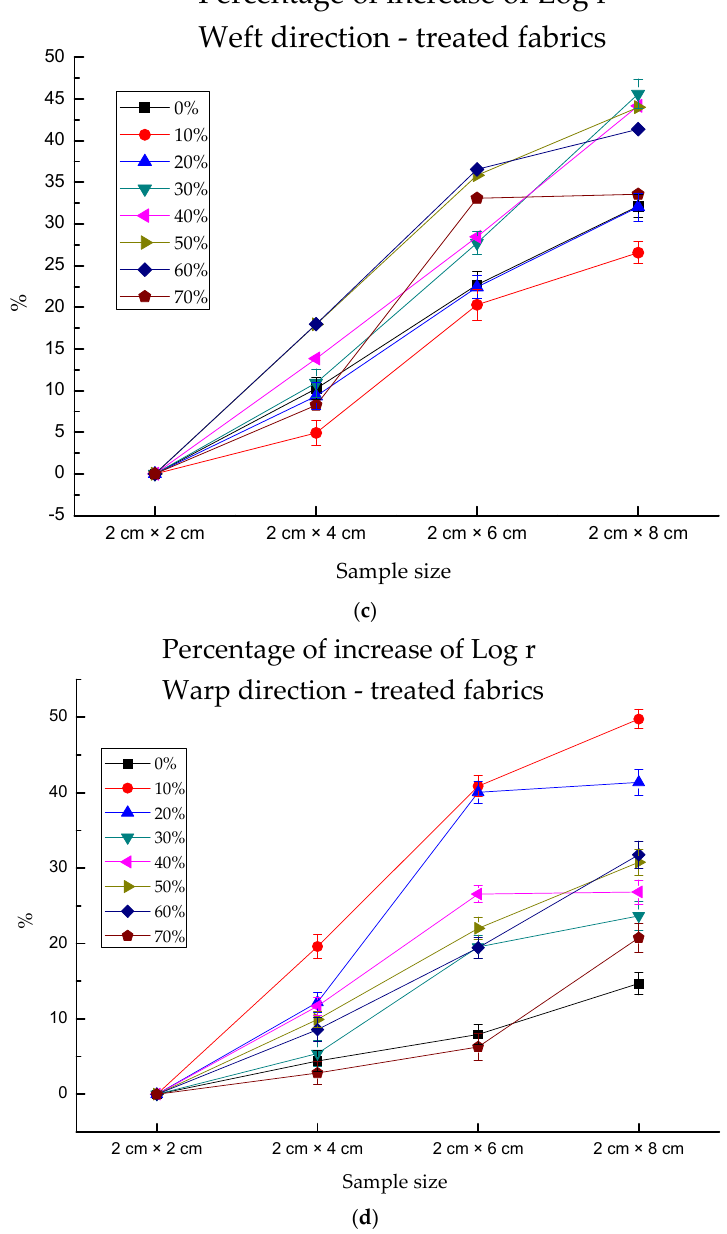
Figure 8. The increased percentage of log (electrical resistance) for each sample in the warp and weft directions when comparing the samples with different sizes under varying water absorption conditions.